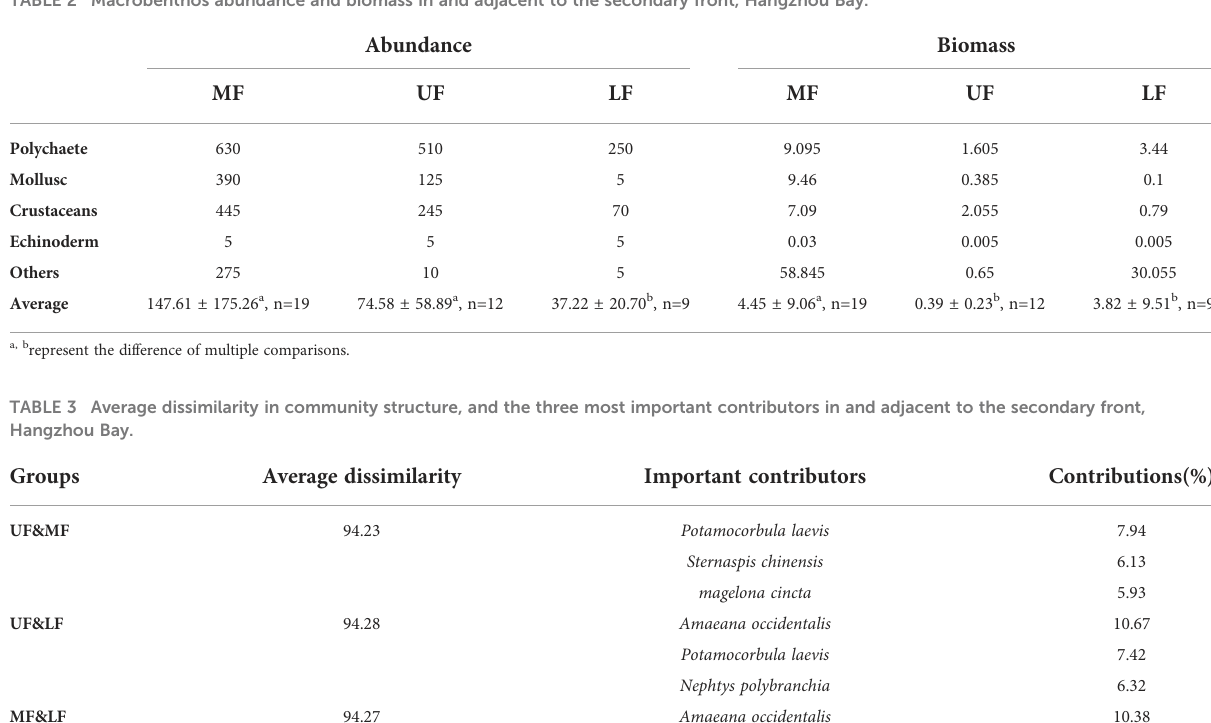
TABLE 2 Macrobenthos abundance and biomass in and adjacent to the secondary front, Hangzhou Bay.